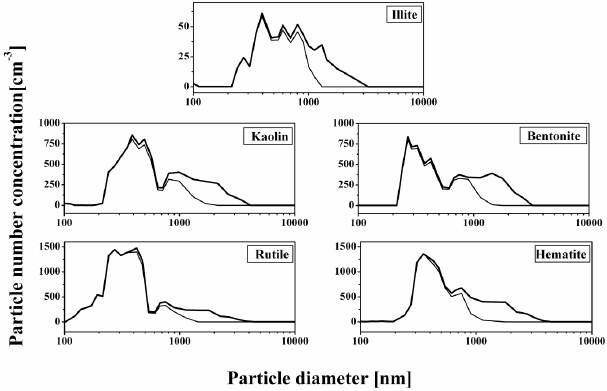
Figure 3. Aerosol optical absorption coefficients. The points repre- sent OAC data calculated from PA signals with error bars represent- ing the uncertainty of the OAC data (see text for details); the black and grey lines represent the Mie-theory-based calculations with or without size correction (SC – taking into account the size transfer function of the PA system), respectively. The dashed grey lines rep- resent the results of calculations by using alternative RI parameters (see text for